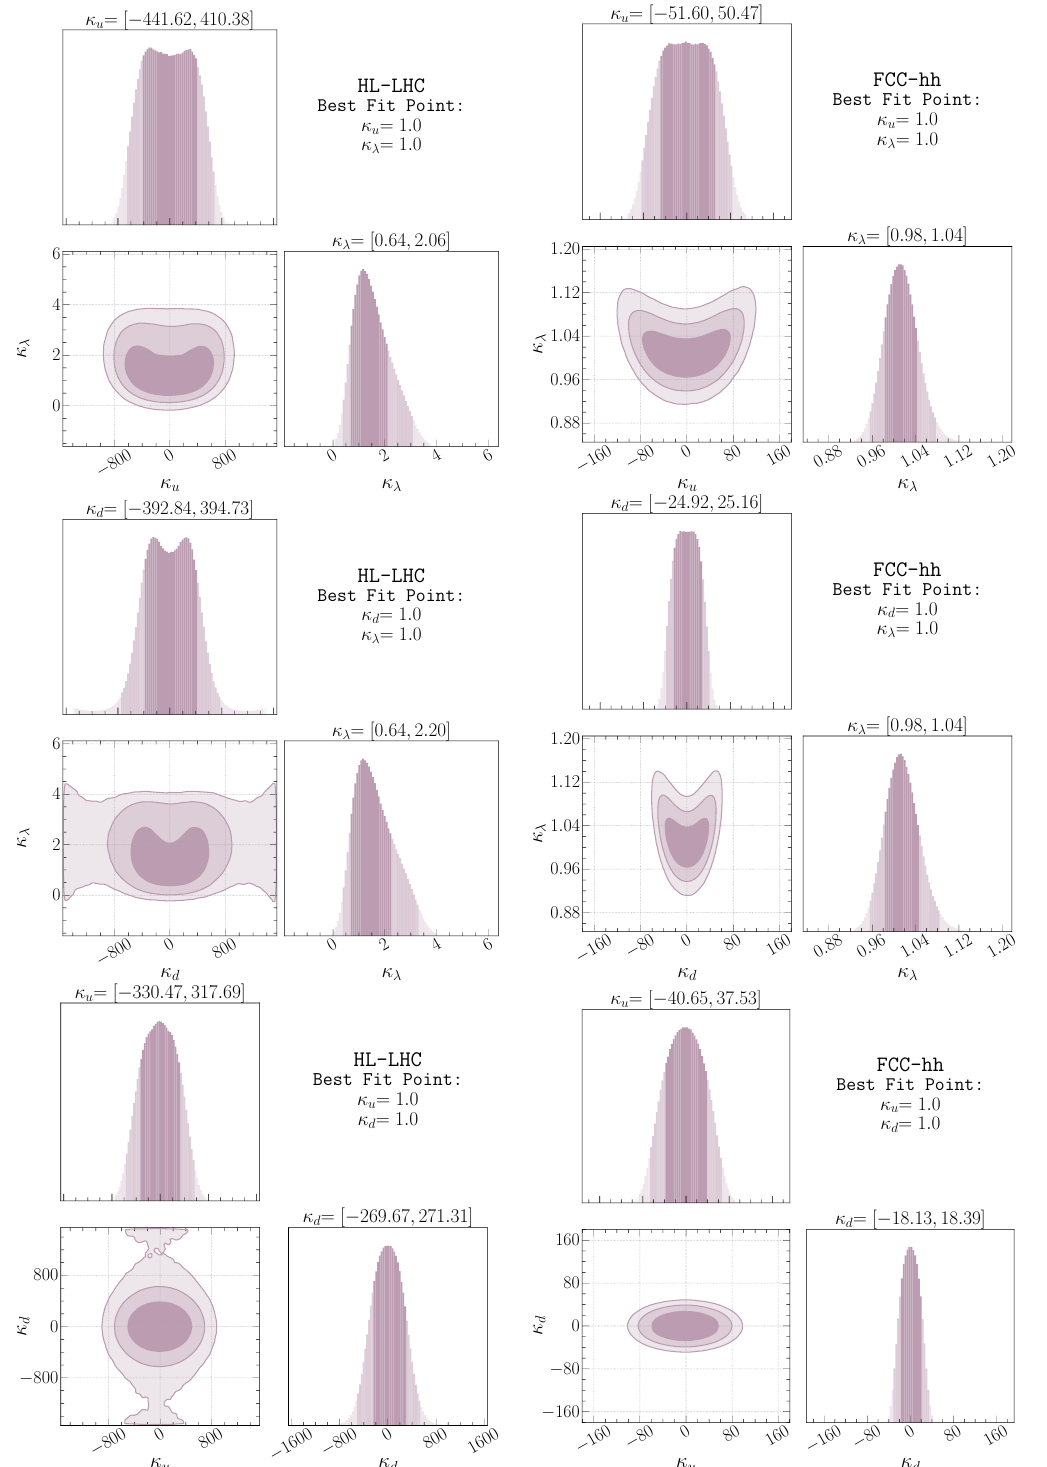
Figure 6 . Constraints on pairs of Wilson coefficients for κ λ , κ u and κ d , The panels on the left are for HL-LHC with 6 ab − 1 of luminosity and the ones on the right are for FCC-hh with 30 ab − 1 of luminosity. The one-dimensional distributions are derived from the two-dimensional distributions by marginalization using uniformly distributed priors for the independent variables with ranges sufficiently large to accommodate much more than 5 σ variation of the variables from their central